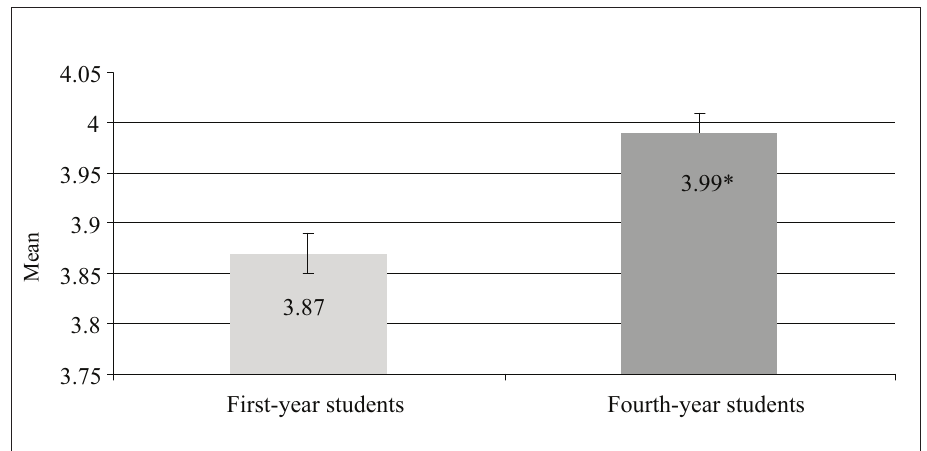
Figure . Mean scores of the level of career self-efficacy among the first and fourth-year students